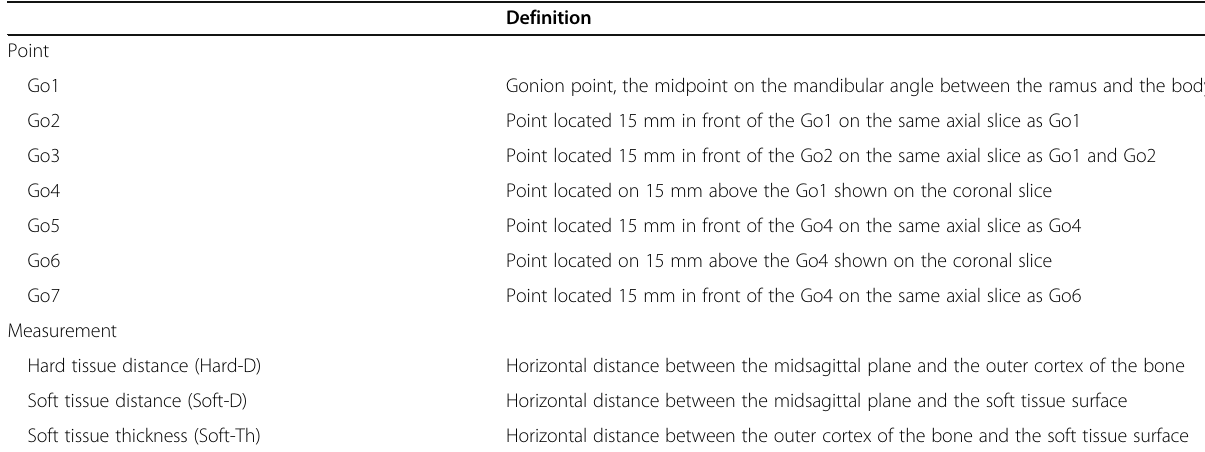
Table 2 Definition of landmarks and measurements used in this